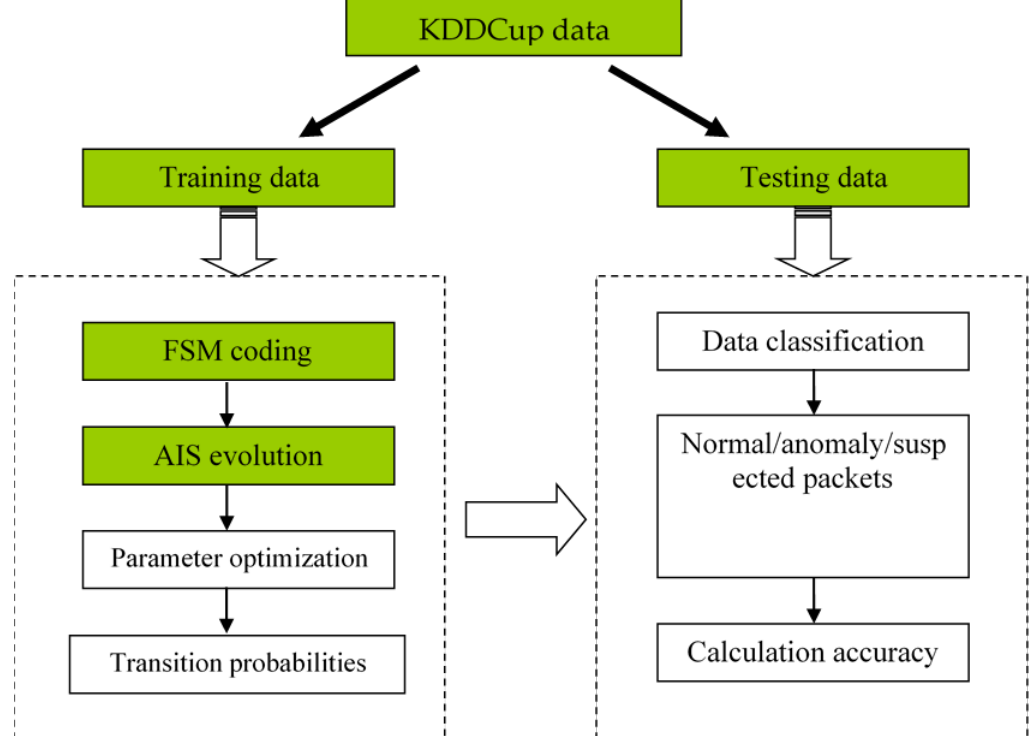
Figure 1. Procedures for the intrusion detection experiment. A dataset is divided to training and testing sets. The training set is used to adjust transition probabilities of FSMs via AIS according to known attack types. The testing set is used to calculate classification accuracy of trained FSMs by pretending that the attack types were unknown.